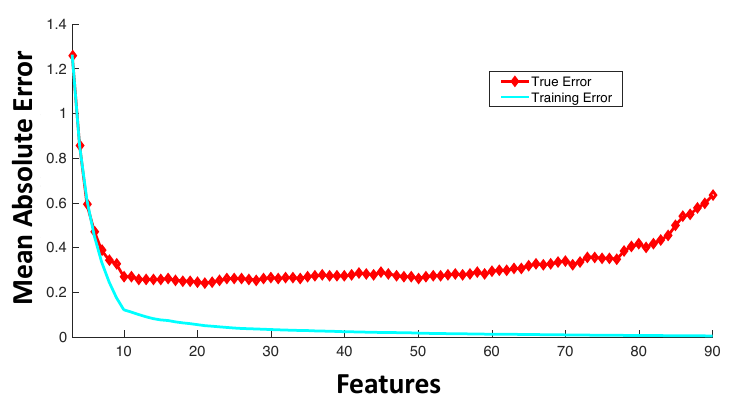
Figure 3. Average trajectory of generalization and training error with the increase in the number of features with a fixed number of training